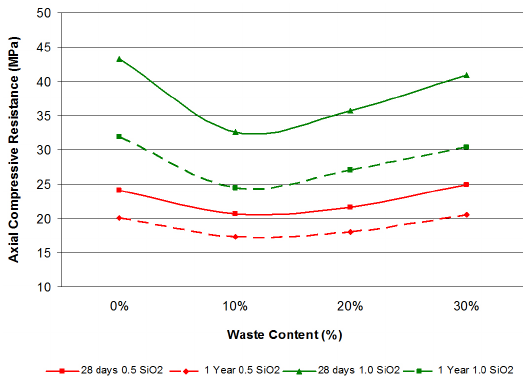
Figure 7. Variation in the compressive strength of magnesium phosphate cement mortar artificially aged for a period equivalent to one year, as a function of waste content added to the samples, compared with specimens with natural age of 28 days.